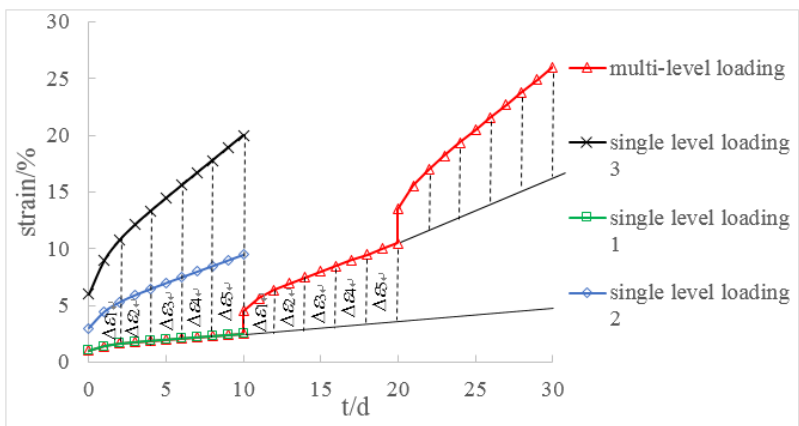
Figure 5. Illustration of multi-step loading method. Plot shows strain super-position process for three stages.